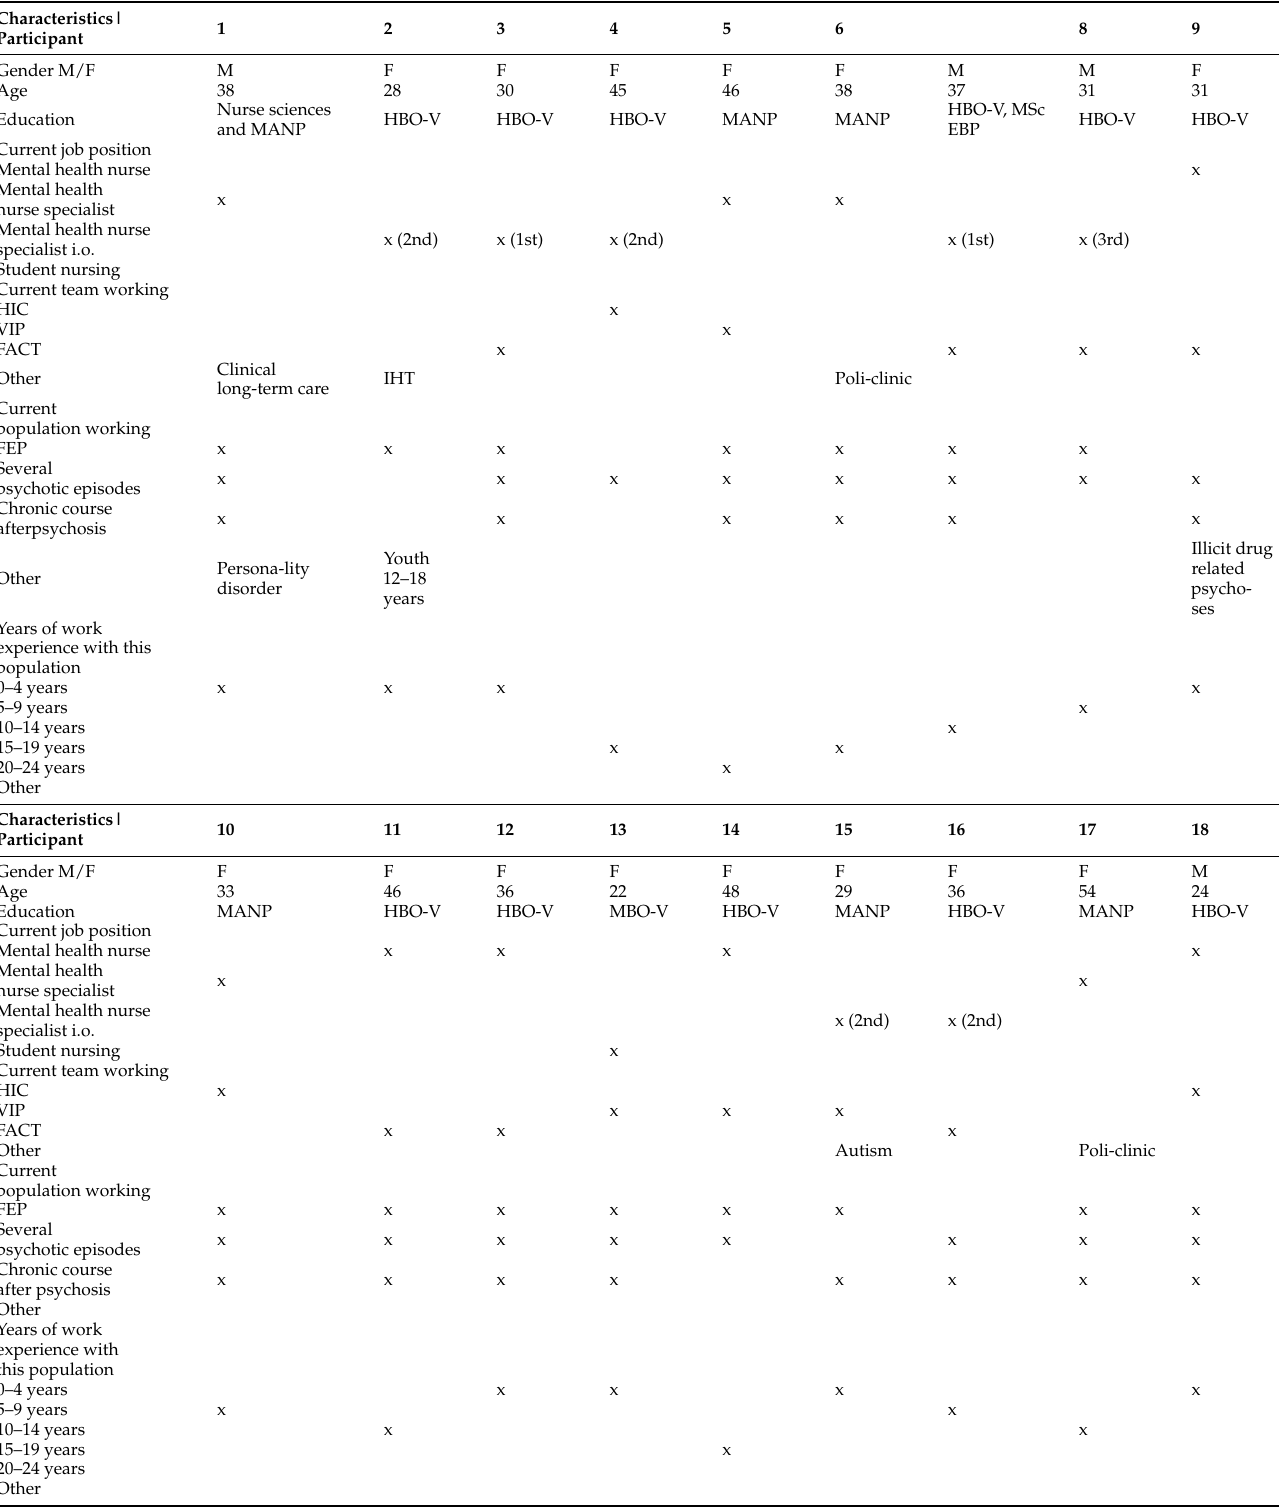
Table A2. Background Characteristics Participants Semi-Structured Interviews (n =